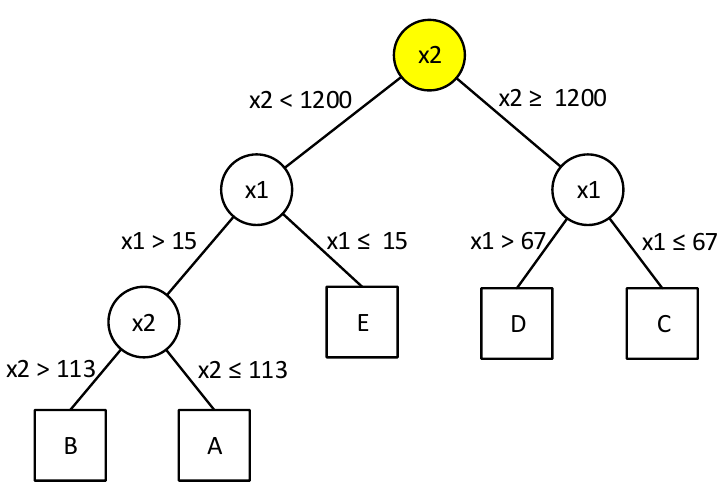
Figure 17. Decision tree example.